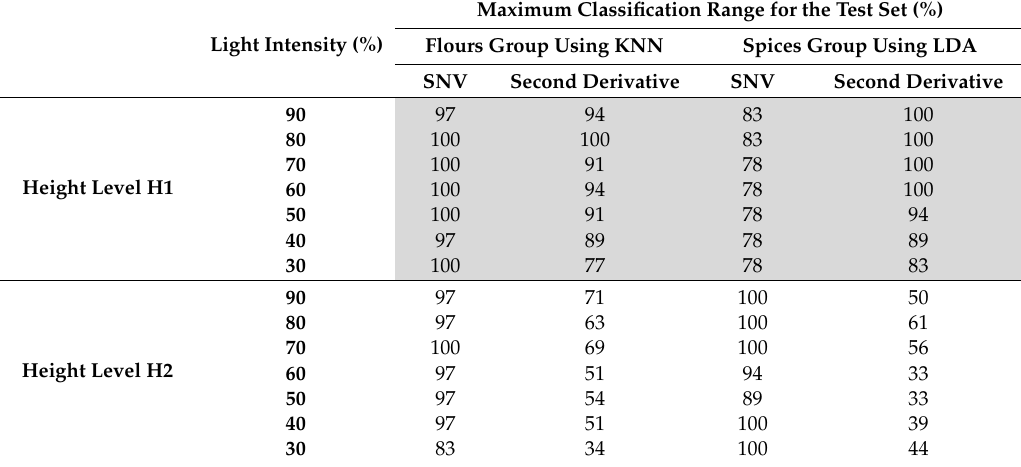
Table 6. Maximum classification prediction accuracies for flour samples using KNN and spice samples using Linear Discriminant Analysis (LDA) at di ff erent sensor heights and light intensities using SNV and second derivative pre-processing on the recorded NIR